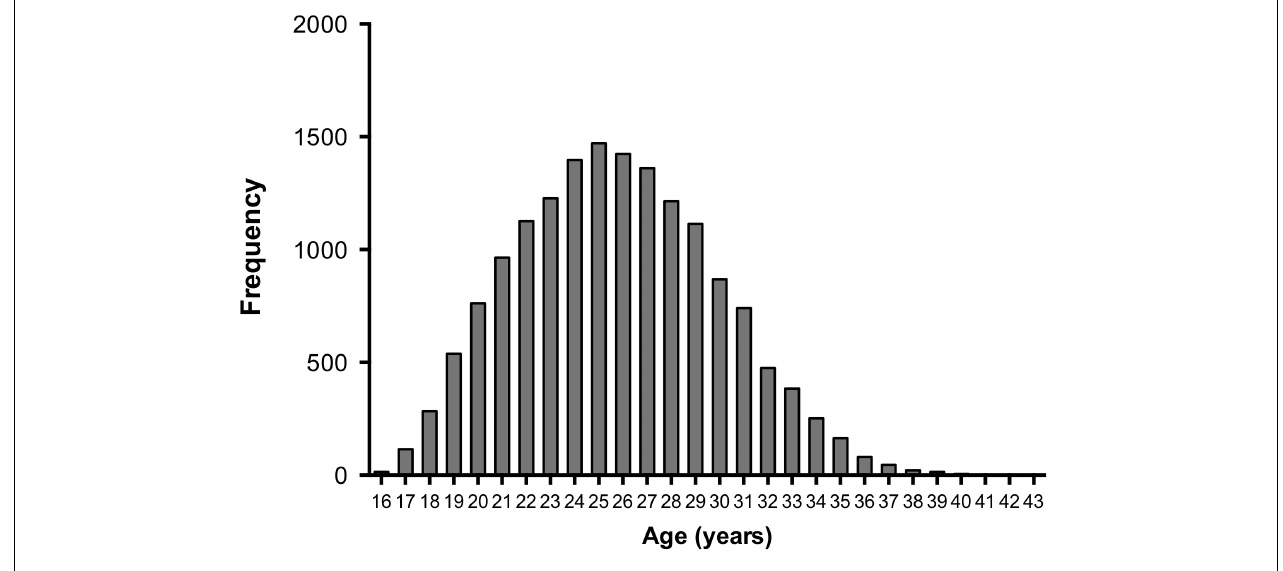
FIGURE 1 | Age distribution of UEFA Champions League players from 1992–1993 to 2017–2018.